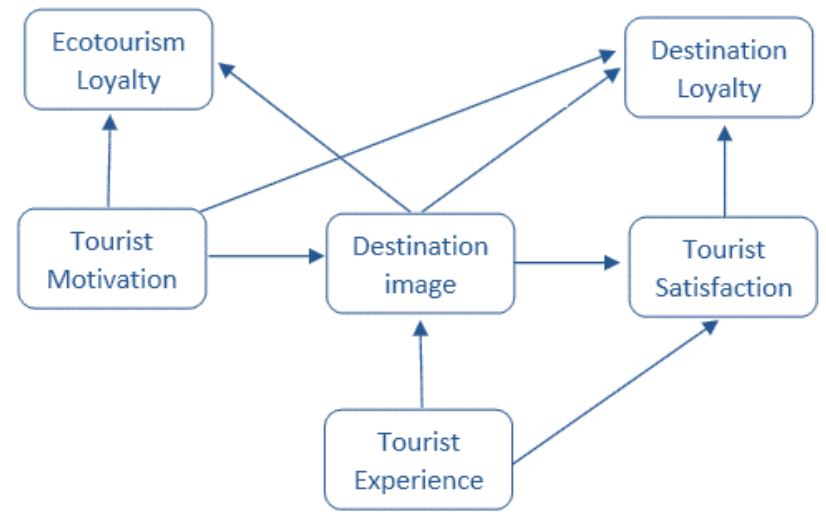
Figure 1. Conceptual framework